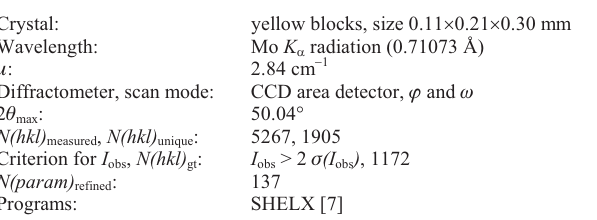
Table 1. Data collection and handling.